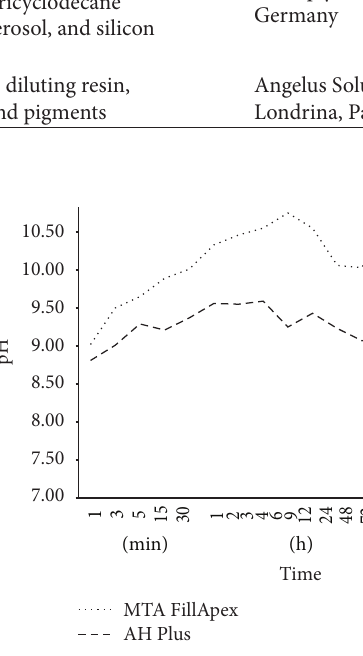
Figure 1: Hidrogenic potential changes of the tested materials according to different periods of time.